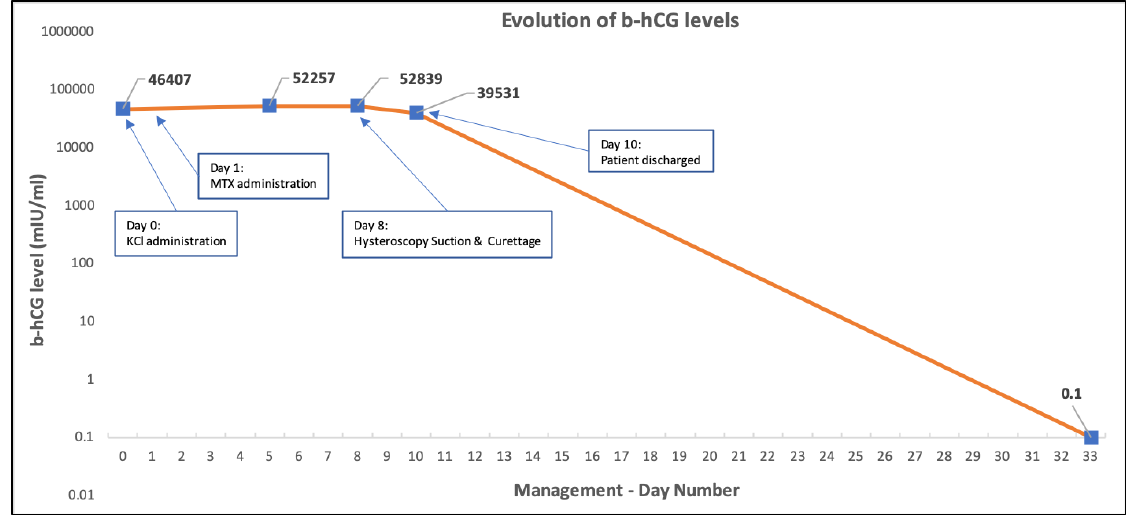
Figure 3. Evolution of b-hCG serum levels since patient’s admission and therapeutic approach.